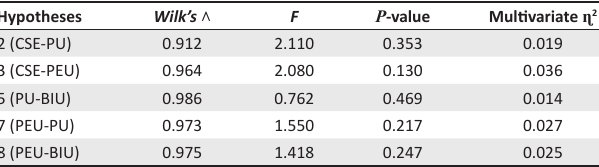
TABLE 5: Multivariate tests.